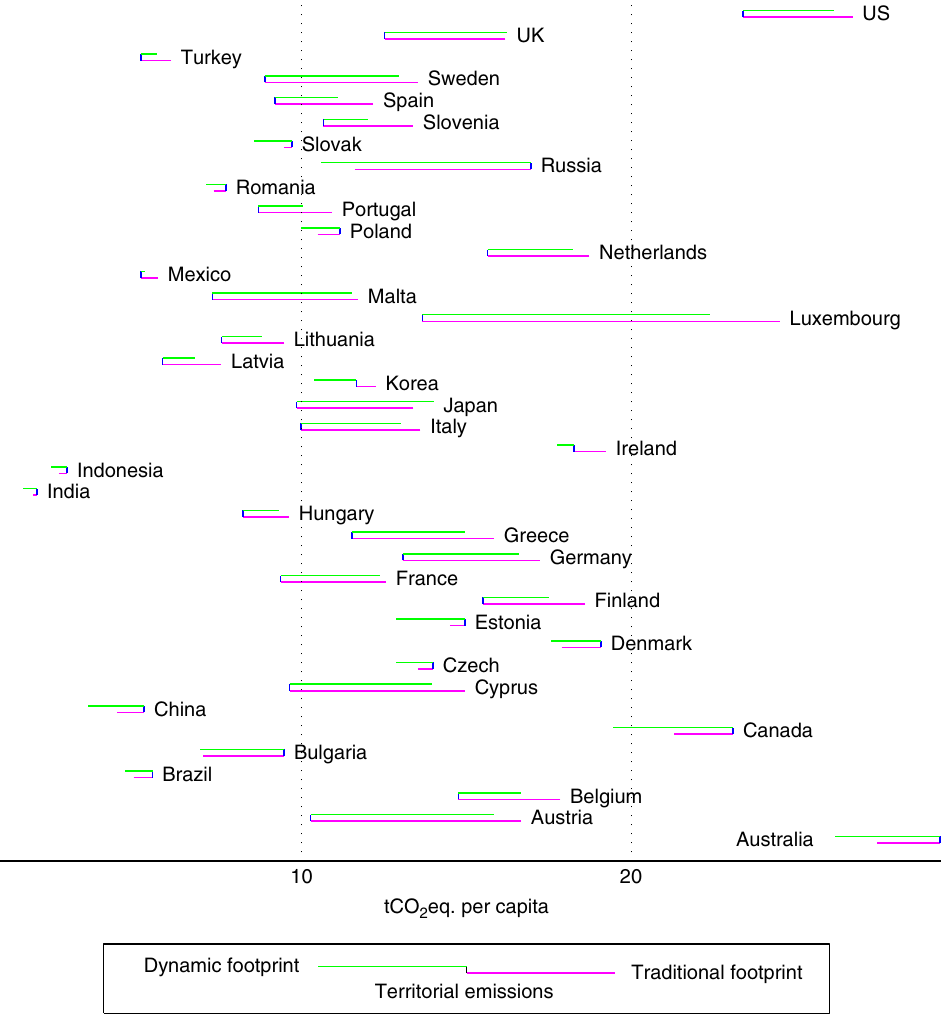
Fig. 4 National per-capita territorial emissions, traditional footprint, and dynamic footprint (average of 1995 – 2009). The position of the vertical short line represents territorial PBA emissions; the free end of the upper line represents the country ’ s dynamic footprint; and the free end of the lower line represents the traditional footprint. Values are indicated on the horizontal axis. By way of an example, China ’ s dynamic footprint is lower than its traditional footprint, while both CBA measures are lower than is territorial PBA